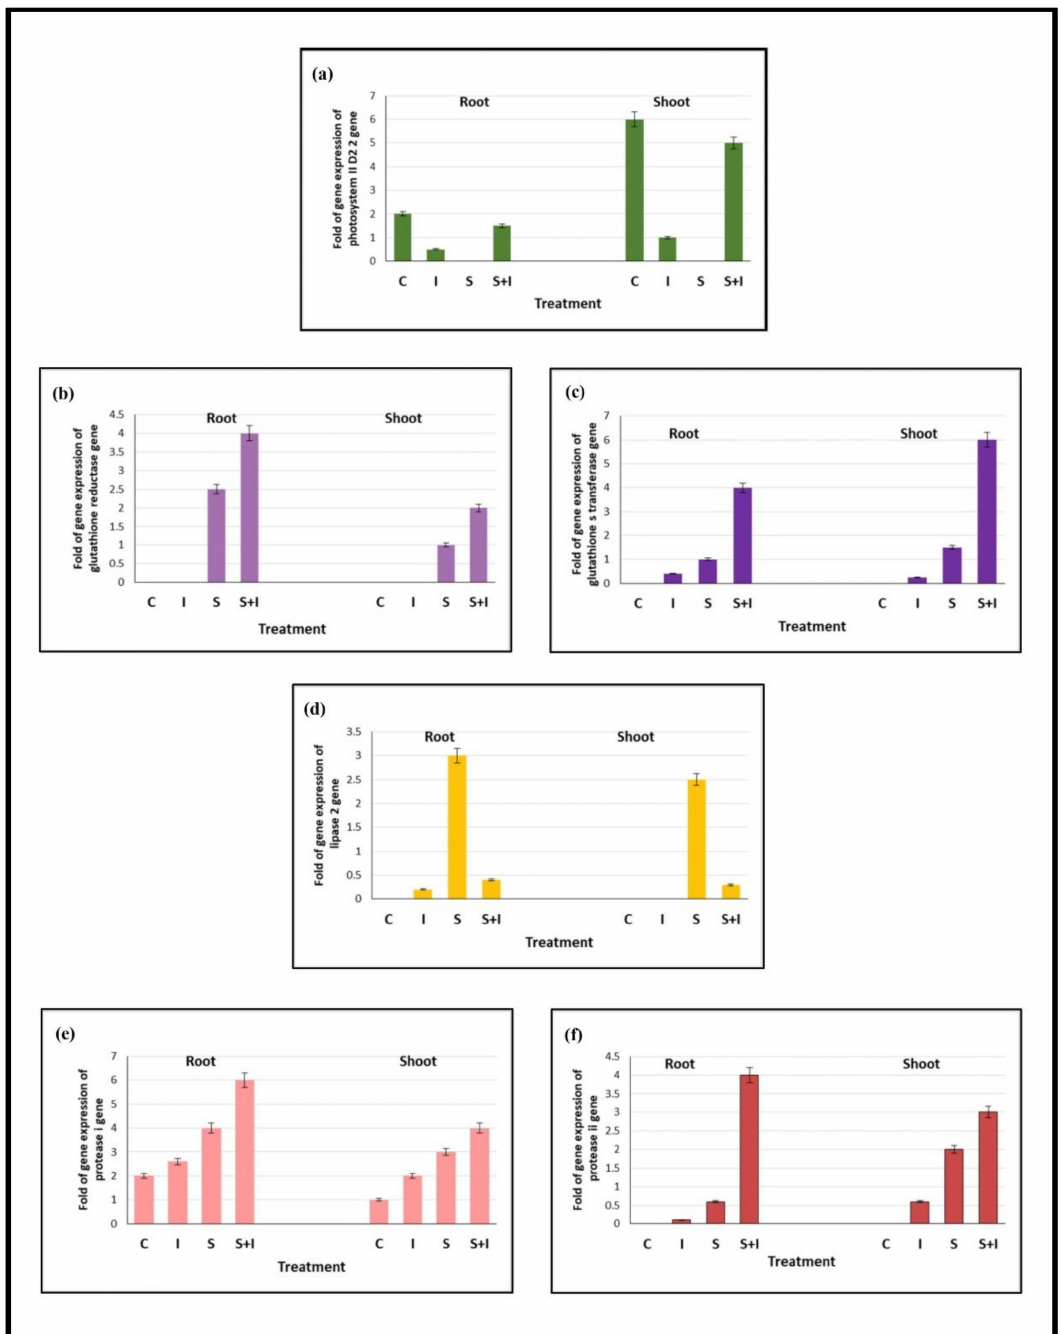
Figure 4. Effect of 0 (C), selected bioinoculum (I), 200 mM NaCl (S), and their interactions on the gene expression of PSII D2 ( a ), glutathione reductase (GR) ( b ), glutathione S transferase (GST) ( c ), lipase ( d ), protease I ( e ), and protease II ( f ) in the roots and shoots of S. melongena L. plants 66 days after sowing. Values are means ± SE based on triplicate independent